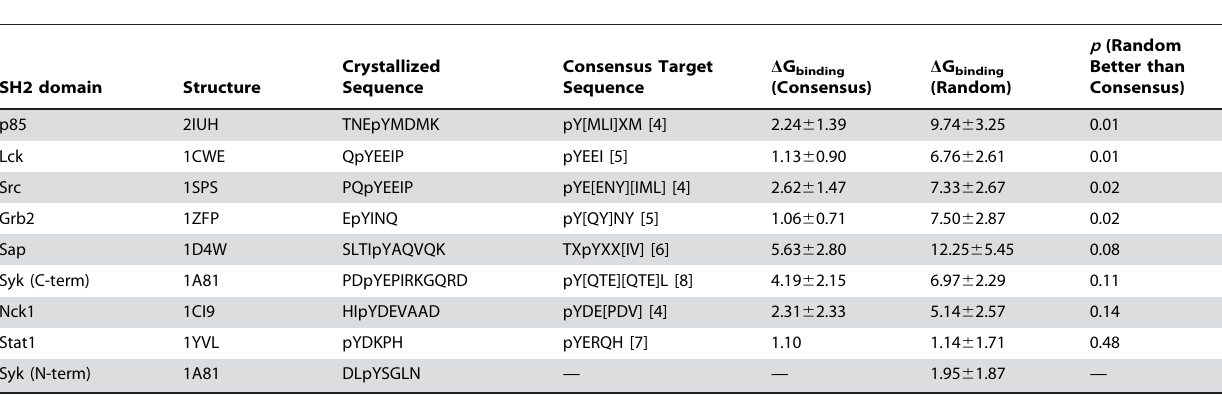
Table 1. Comparison of experimental consensus target sequences with FoldX predictions of binding specificity for human SH2